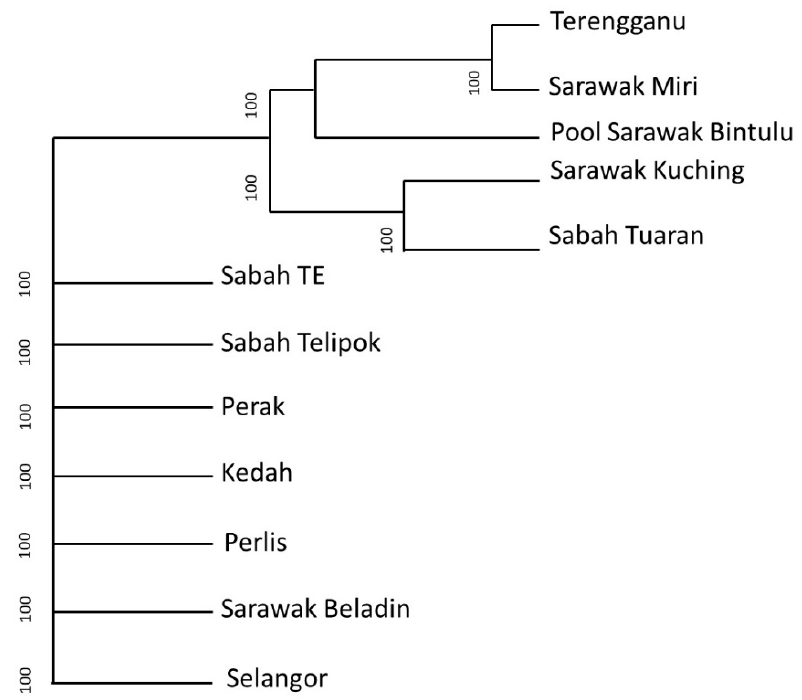
Figure 7. Phylogenetic tree dendrogram based on trnL using Bray–Curtis distance (at family level).